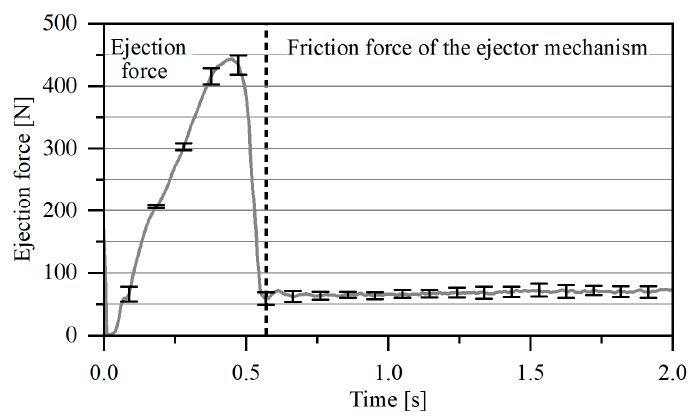
Figure 3. Force-time curve of an exemplarily chosen demolding processes of a polypropylene (PP) part from a CrAlN coated quadratic core.